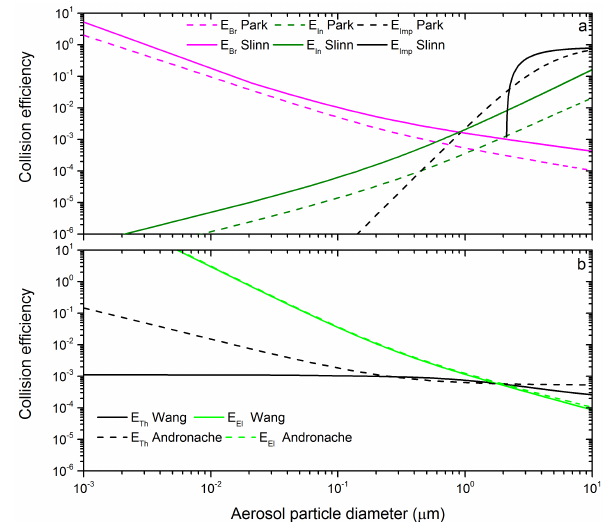
Figure 5. Calculated collision efficiency for a droplet of 80µm di- ameter as a function of aerosol particle diameter at a temperature of 245K and ice saturation. The contributions of Brownian motion, interception and impaction are shown in (a) for the formulations by Park et al. (2005) (P05) and Slinn (1983) (S83). The contributions for thermophoresis and electrophoresis are shown in (b) for the for- mulations by Andronache et al. (2006) (A06) and Wang et al. (1978)